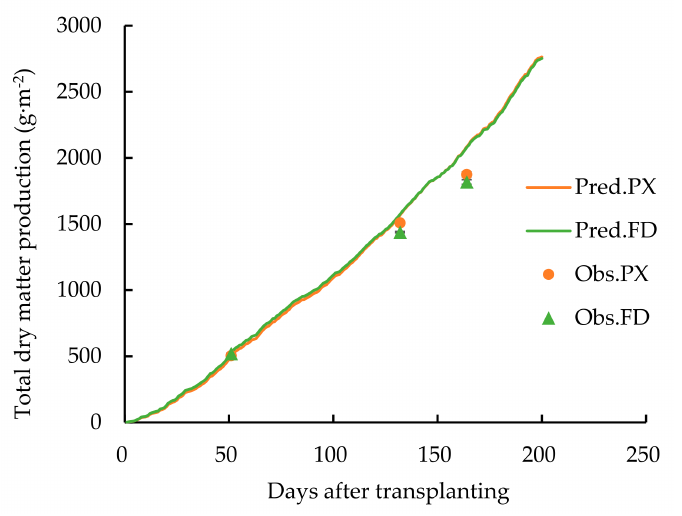
Figure 6. Predicted and observed TDMs in two cucumber cultivars. Observed TDM shows the average ± SE (51, 132, and 163 d after transplantation, n =